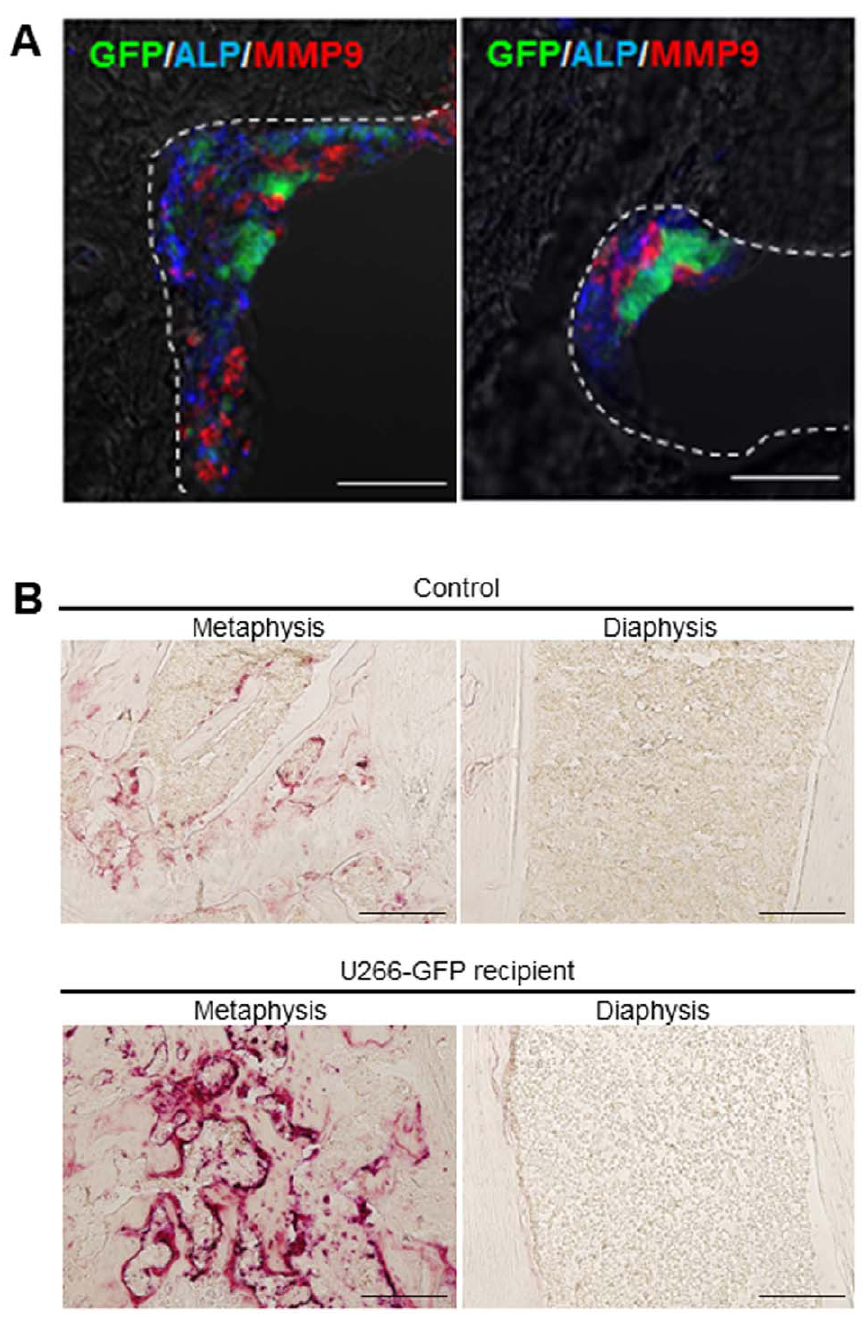
Figure 2. Dynamics of osteoblasts and osteoclasts at the MM niche. A. Triple IHC of GFP (green), ALP (blue) and MMP-9 (red) in the metaphyseal region at 2 weeks after U266-EGFP cell transplantation. Myeloma cells form a cellular complex with osteoblasts and osteoclasts in vivo . Representative data from 10 to 20 fields from the BM of two mice from three independent experiments are shown. Bars=50 m m. B. Regional differences in TRAP-positive osteoclast cells in the long bones. Micrographs of TRAP staining of the metaphysis and the diaphysis at 4 weeks after U266-EGFP cell transplantation. Whereas the development of TRAP-positive osteoclast cells is barely discernable in the diaphysis region, a number of TRAP-positive osteoclast cells are evident in the metaphysis region. The experiment was performed three times with similar results. Bars=200 m m.